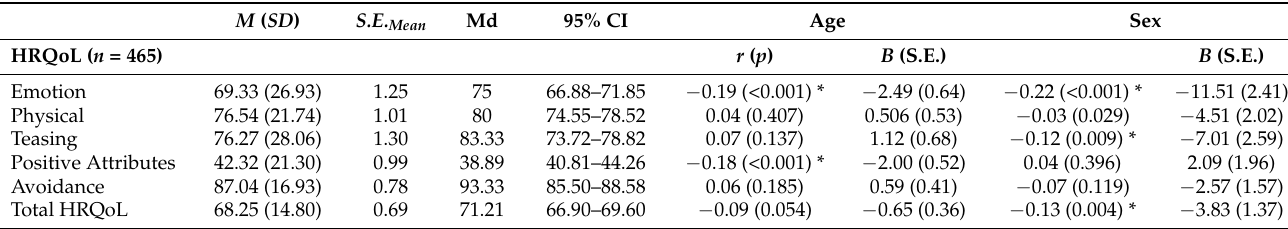
Table 2. Health-Related Quality of Life and Covariates.